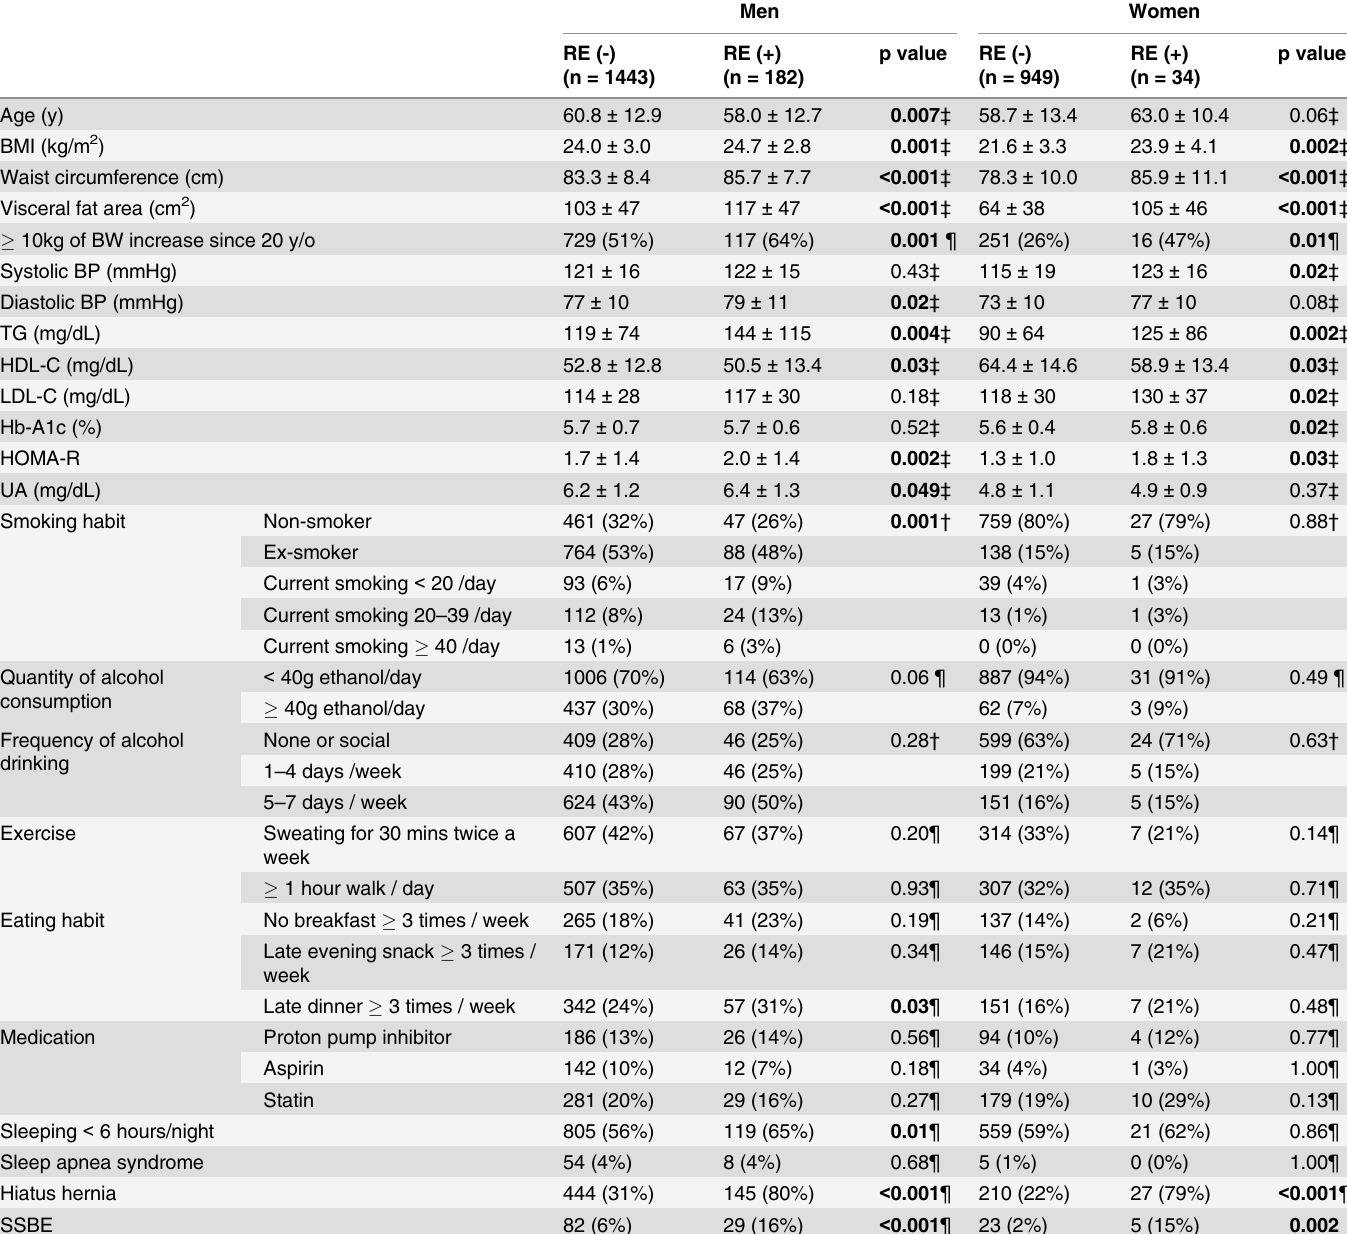
Table 1. Differences between participants with and without reflux